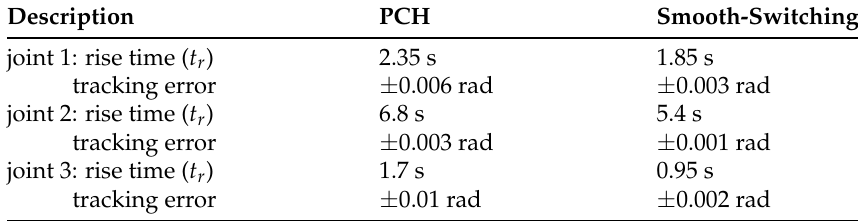
Table 6. Performance indexes of FL, PCH and smooth-switching with q d = 1 + 0.5sin ( π t )